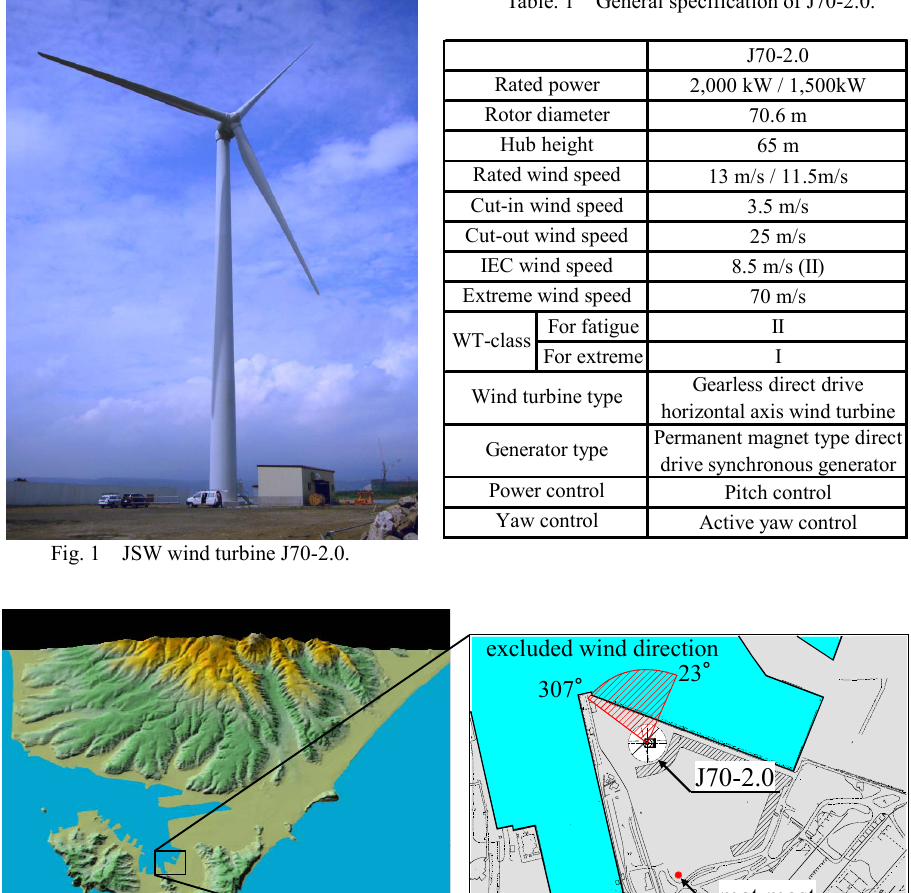
Table. 1 General specification of J70-2.0.